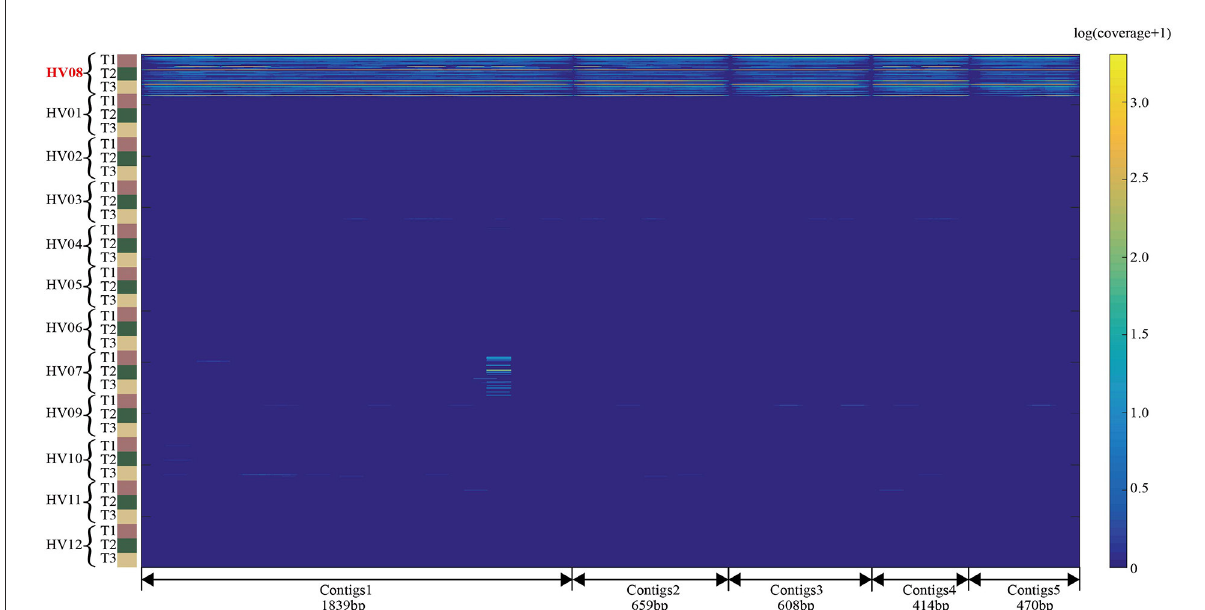
FIGURE7 Coverage heatmap of the 5 HV08-specific contigs aligned by the 499 human skin samples from 12 healthy individuals. The coverage is the read-alignment depth in each nucleotide normalized by the number of million reads. To avoid the effect of a large span, we used the logarithm of (coverage + 1) as the numerical value of the heatmaps. The horizontal axis is composed of each nucleotide of the 5 sequences, and the vertical axis is composed of each sample from each individual. The upper part of the heatmap is individual HV08, and the lower part is comprised of the other